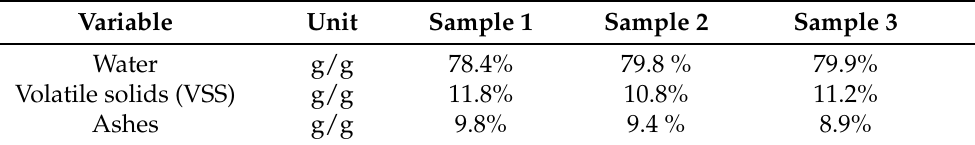
Table A2. Composition of biosolids on Day 0.